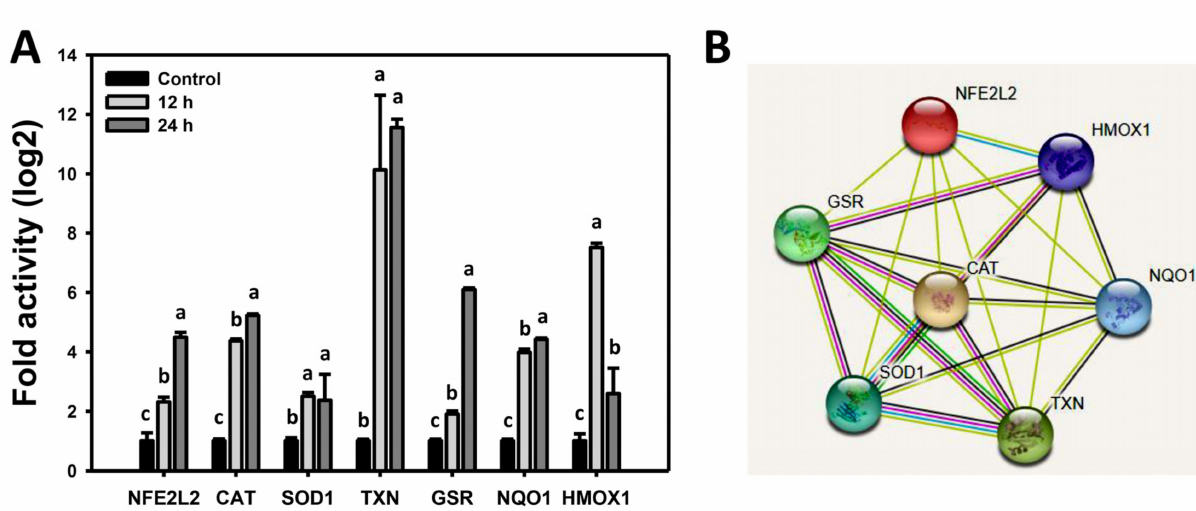
Figure 7. Gene expression and relationship between antioxidant signaling in WFA-treated bladder cancer cells. ( A ) Real- time PCR analysis. Cells were pretreated and post treated with NAC (8 mM, 1 h) and WFA (0 and 10 µ M for 12 and 24 h), respectively. Subsequently, real-time PCR for mRNA expression in these drug-treated cells was performed. Data, mean ± SD ( n = 3). Columns showing non-overlapping lower-case letters indicate p < 0.05 for multiple comparisons. ( B ) Bioinformatics analysis using STRING protein–protein